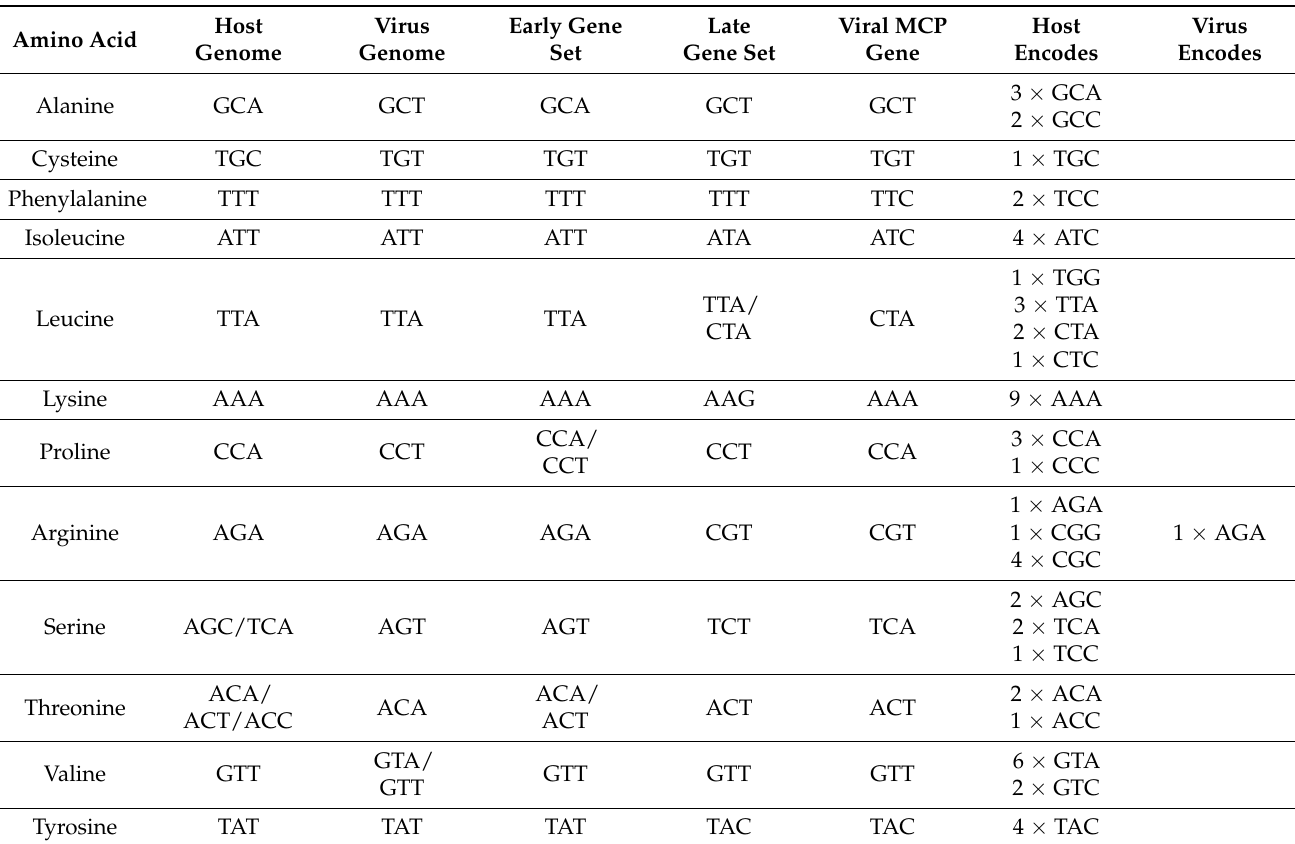
Table 1. Preferred codons that were utilized differently between the host genome, virus genome, the set of early- or late-infection-stage genes, and the viral major capsid protein (MCP)